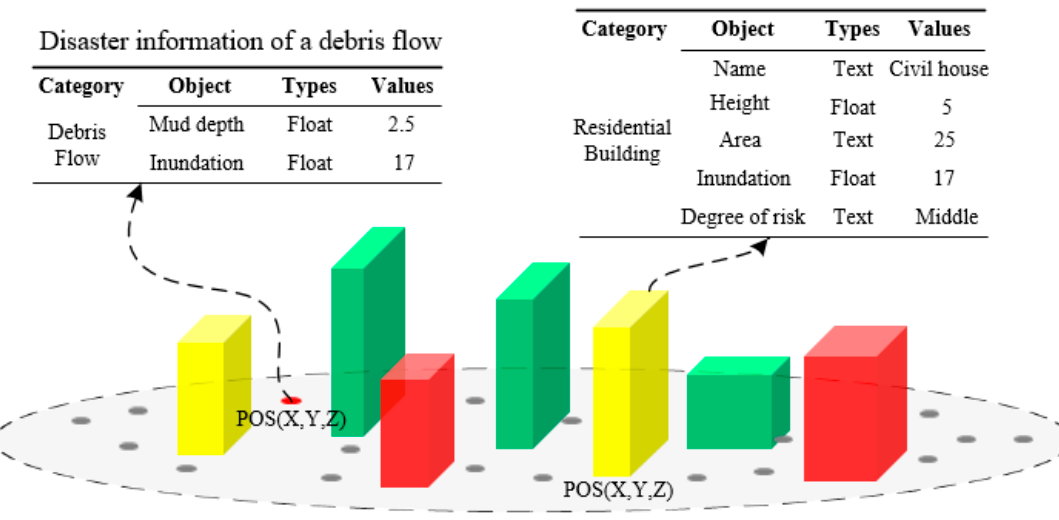
Figure 6. Fusion of disaster information with attribute category constraints.